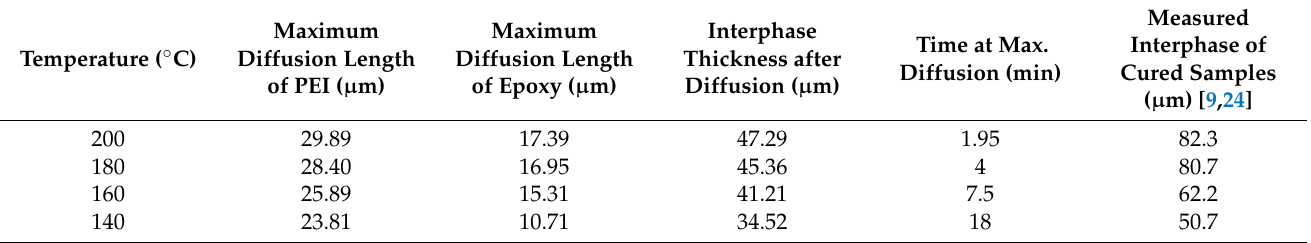
Table 2. Overview of important values derived from reactive multicomponent diffusion experiments.